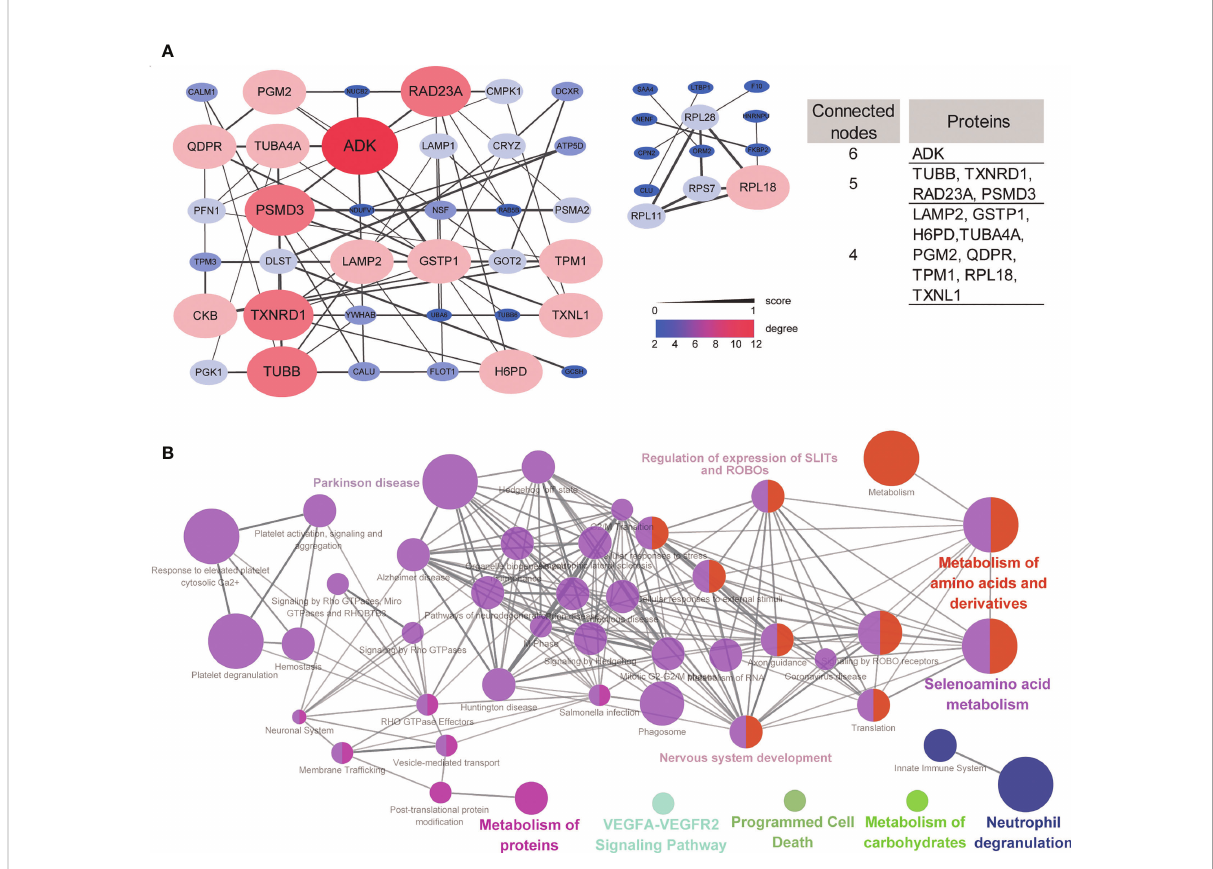
FIGURE 4 Protein – protein network and network of terms/pathways. (A) Protein – protein interaction networks of up- and downregulated signatures, and DEPs with connected nodes >3 were listed. (B) Network of terms/pathways identi fi ed using ClueGO highlighting the terms/pathways of differentially expressed